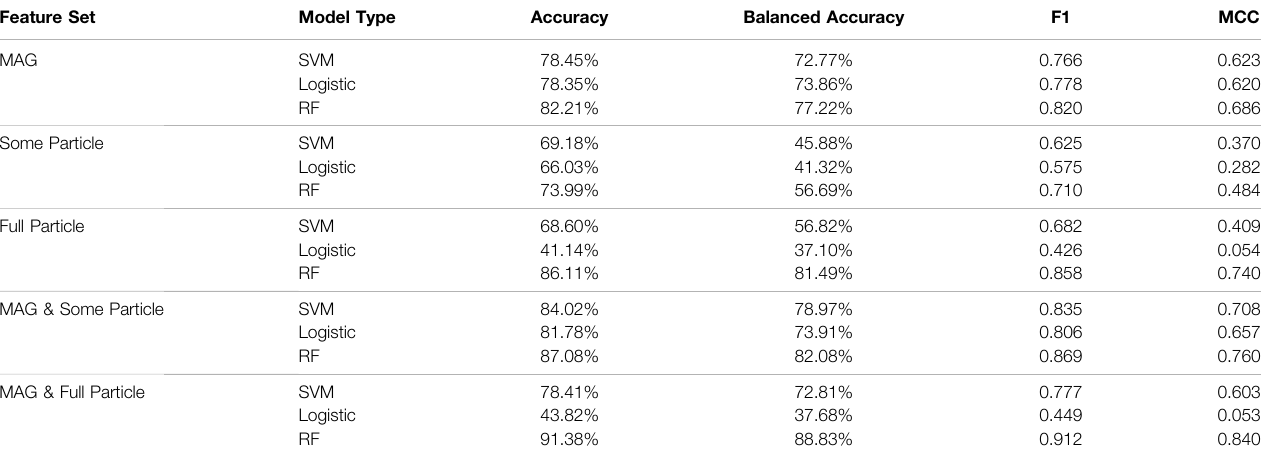
TABLE2| ComparisonofSVM,LogisticRegressionandRFmodelsusingvariousfeaturesetsasdescribedintheMethodssection.Dependingonthefeaturesetsused,the amount of training and test data available will change, however all the time intervals used for training and testing are consistent across the different feature sets. Feature Set Model